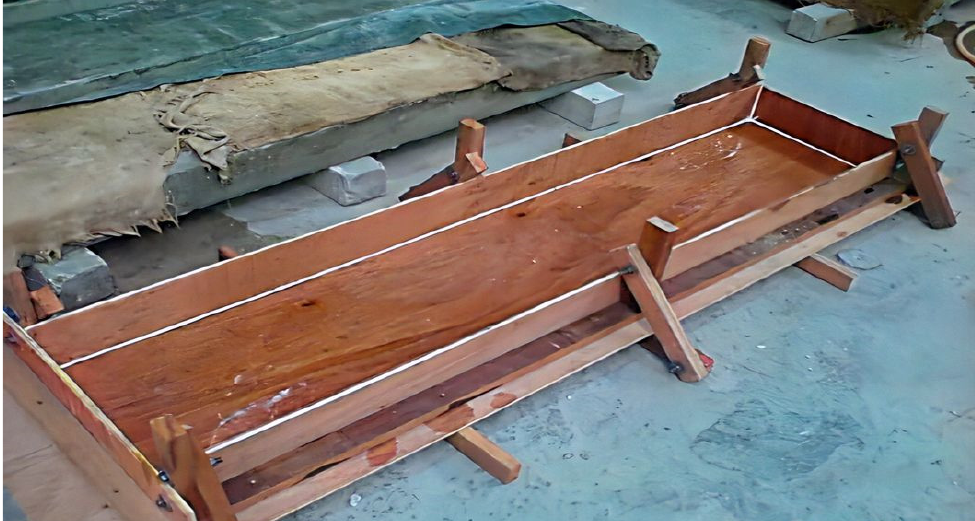
Figure 3. Illustration of wooden formwork for concrete specimen casting.